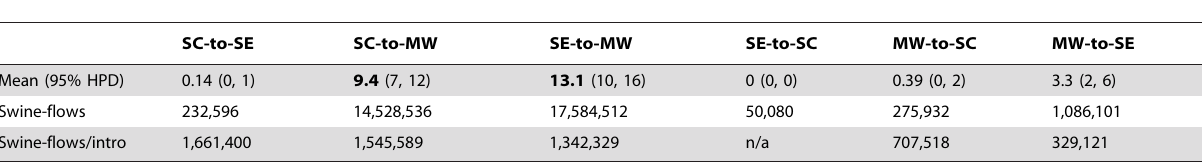
SC-to-SE SC-to-MW SE-to-MW SE-to-SC MW-to-SC MW-to-SE